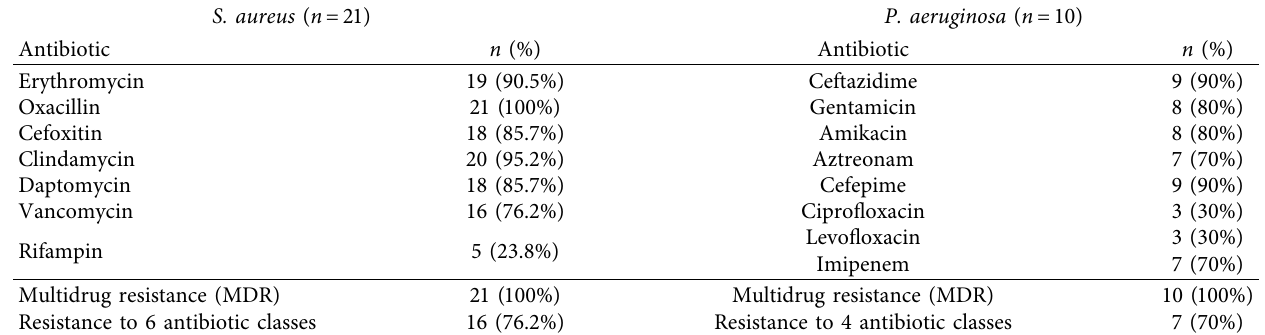
Figure 1: Distribution of bacterial isolates from open fractures ( n � 51). Table 2: Antimicrobial susceptibility pattern of S. aureus and P. aeruginosa isolated from infected open fractures.